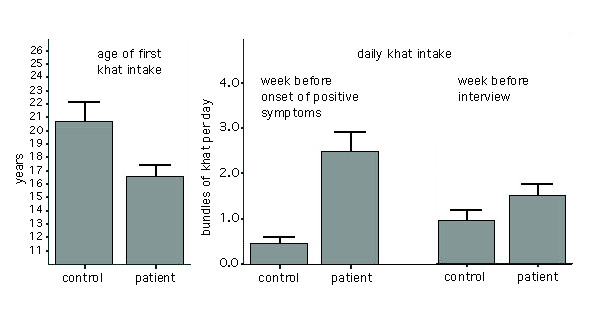
Patterns of khat consumption. Left: age of first khat intake among lifetime chewers in patients with psychotic symptoms (35) and case controls (23); right: amount of khat use (in 'bundles' per day) in the week before the onset of first positive symptoms (25 cases with psychotic symptoms, 24 controls) and in the week before the clinical interview (16 cases with psychotic symptoms, 9 controls). Bars indicate mean and standard error.